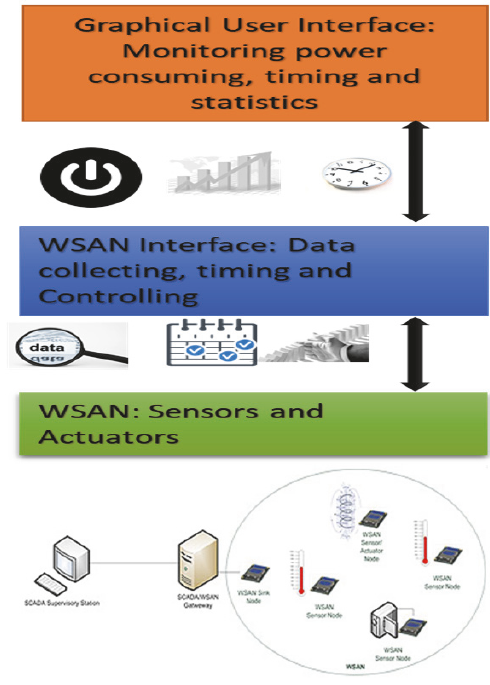
Figure 3: The architecture of energy efficiency system.